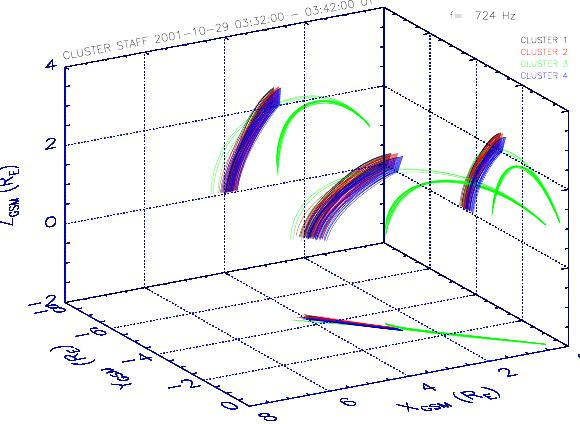
Fig. 9. Plots of the ray traces in 3-D and their corresponding projec- tions on the three planes for the time interval 03:32–03:42UT and for a frequency equal to